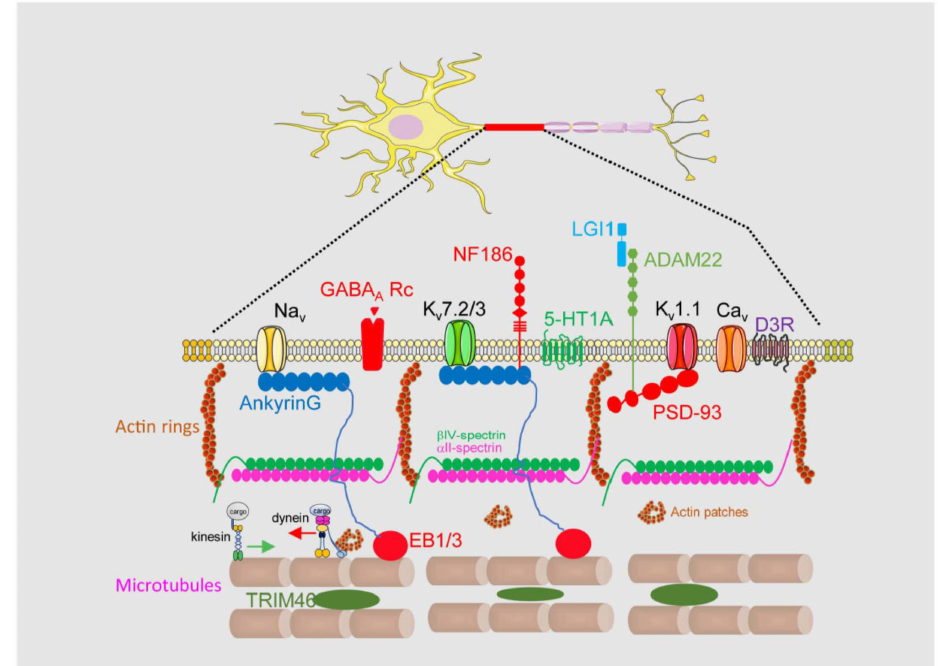
Figure 1. Axon initial segment structural and functional composition. The AIS is located in the first 20 to 60 µ m of the axon and has a differentiated membrane composition with regard to somatodendritic and axonal domains. It is characterized by a high concentration of voltage-gated sodium (Na v ) and potassium (K v ) channels anchored to ankyrinG or PSD-93 scaffold proteins. AnkyrinG links ion channels to microtubules through EB1/3 proteins and to actin cytoskeleton through its binding to β IV-spectrin. The AIS contains also voltage-gated calcium channels (Ca v ), serotonin, dopamine and GABA A receptors. TRIM46 binds microtubules and contribute to their fasciculation. Their special characteristics allows the control of axonal cargoes entry in the